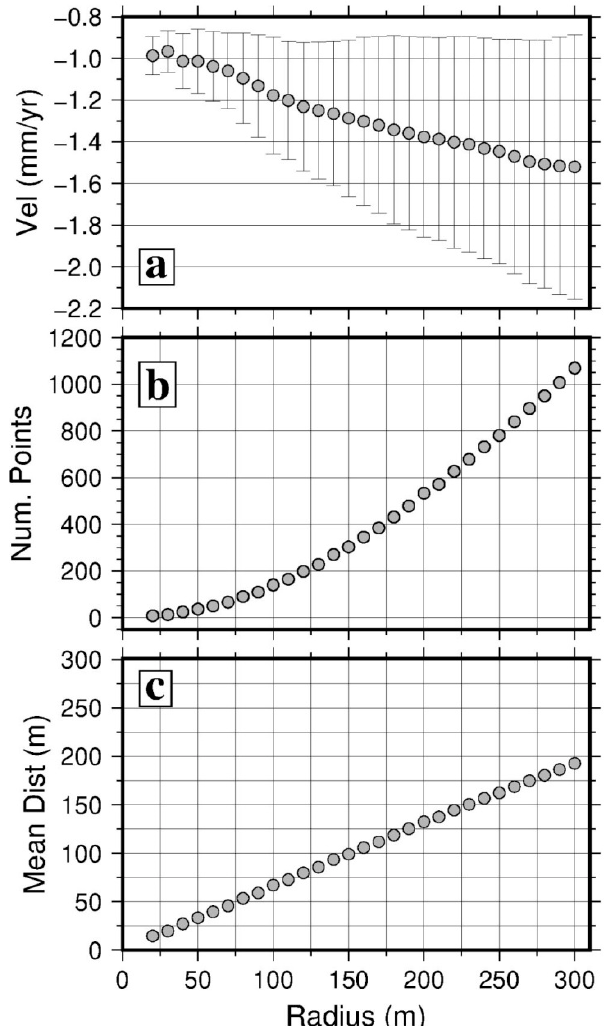
Figure 6. Average InSAR velocity along the LOS direction at the CODI CGNSS site. ( a ) Average velocities with different search radiuses (from 20 m to 300 m, with a step of 10 m); the vertical bars are the calculated Weighted Root Mean Square (WRMS) values; ( b ) Number of InSAR points (Num. Point) used to obtain the average rate; ( c ) The mean distance (Mean Dist.) from the CGNSS site to the points included in the search area.